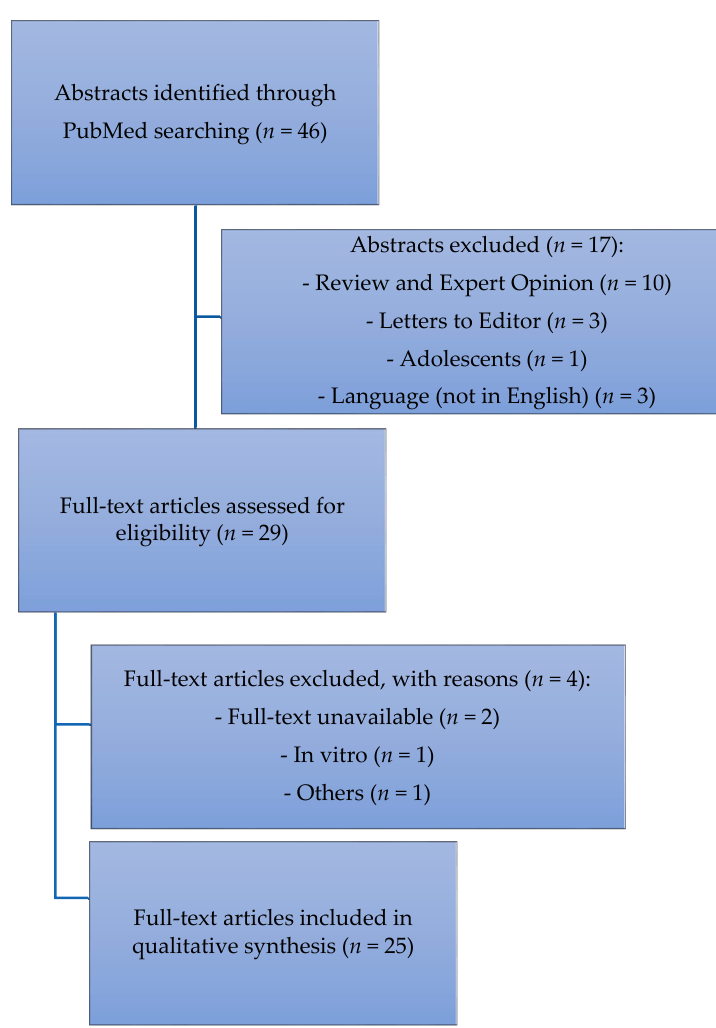
Figure 1. Flow-chart describing the data collection